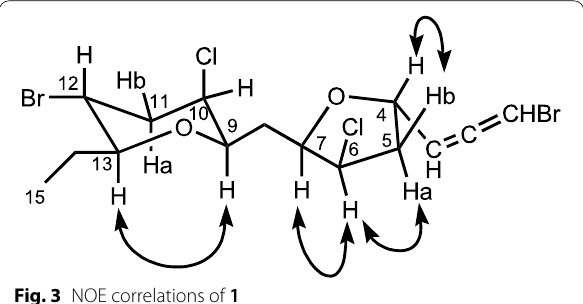
Fig. 3 NOE correlations of